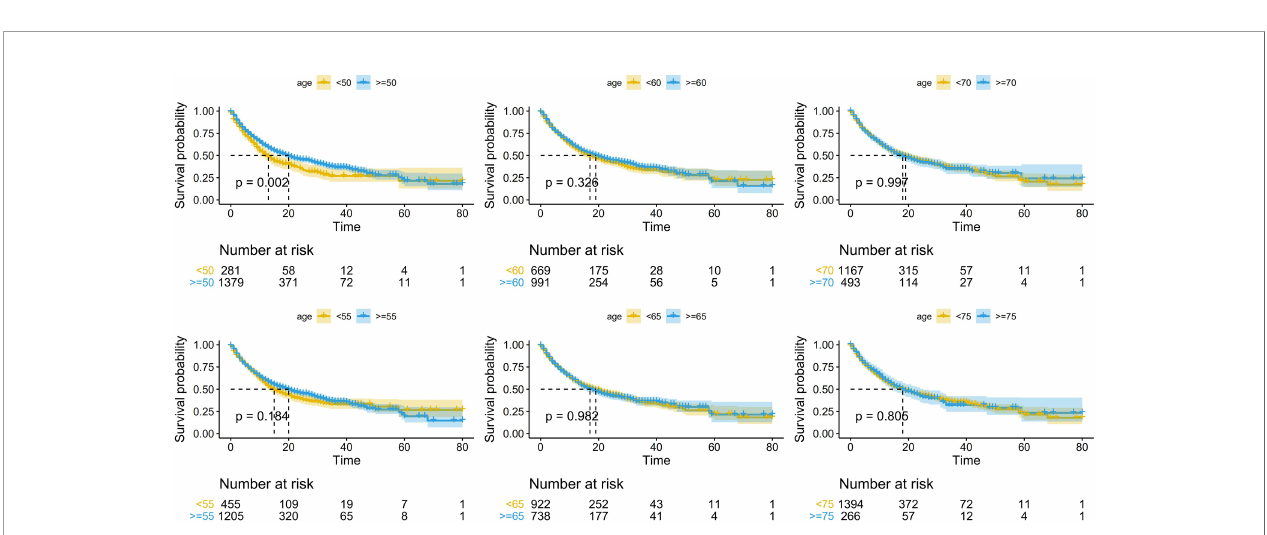
FIGURE 2 | Kaplan-Meier curves depicting overallsurvival (OS; inmonths)according to different age cutoff points in patients receiving immune checkpoint inhibitors